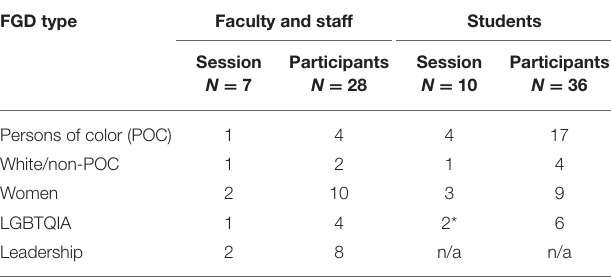
TABLE 1 | Type and number of FGDs and